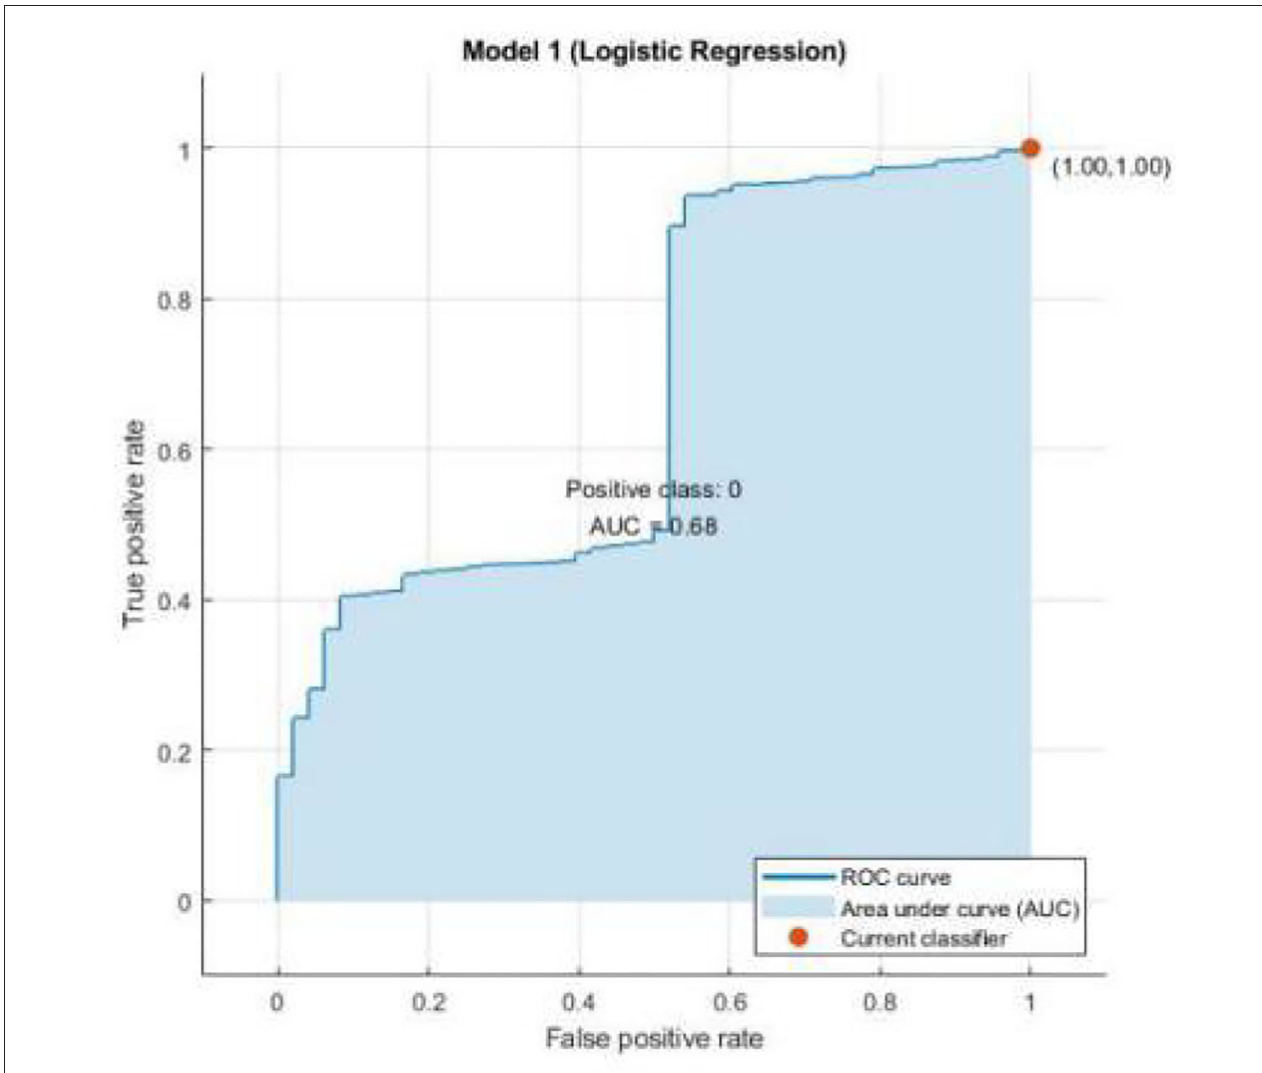
FIGURE 8 | ROC curve from logistic